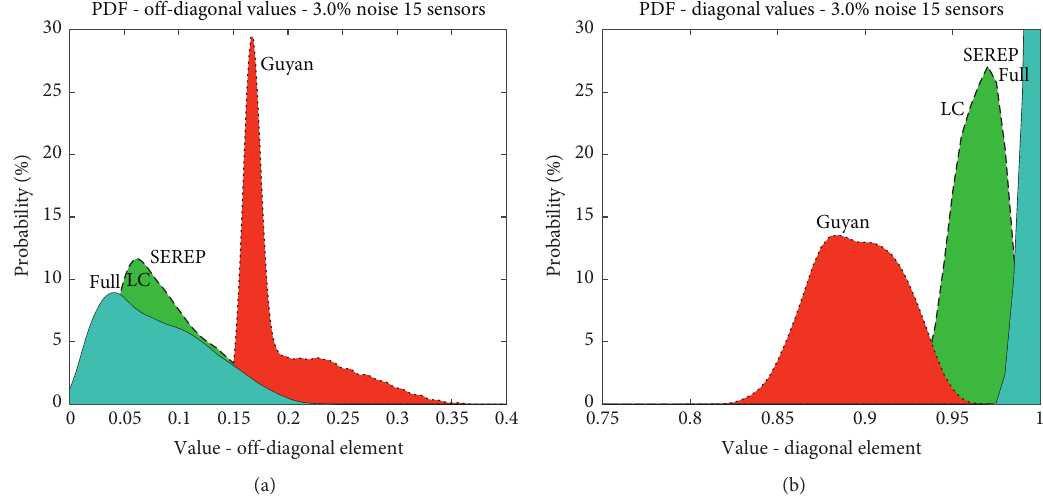
Figure 6: (a) PDFs of the maximal off-diagonal elements. (b) PDFs of the minimal diagonal elements. Both with 3 pct. Noise on the modes and 15 sensors.